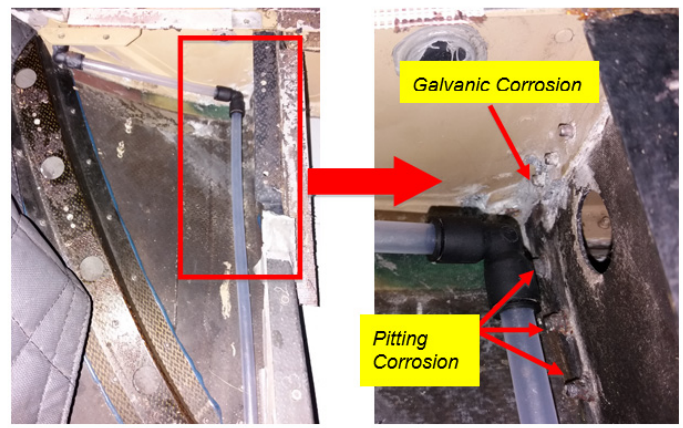
Figure 7. Corrosion at Frame X7225 till X7225.